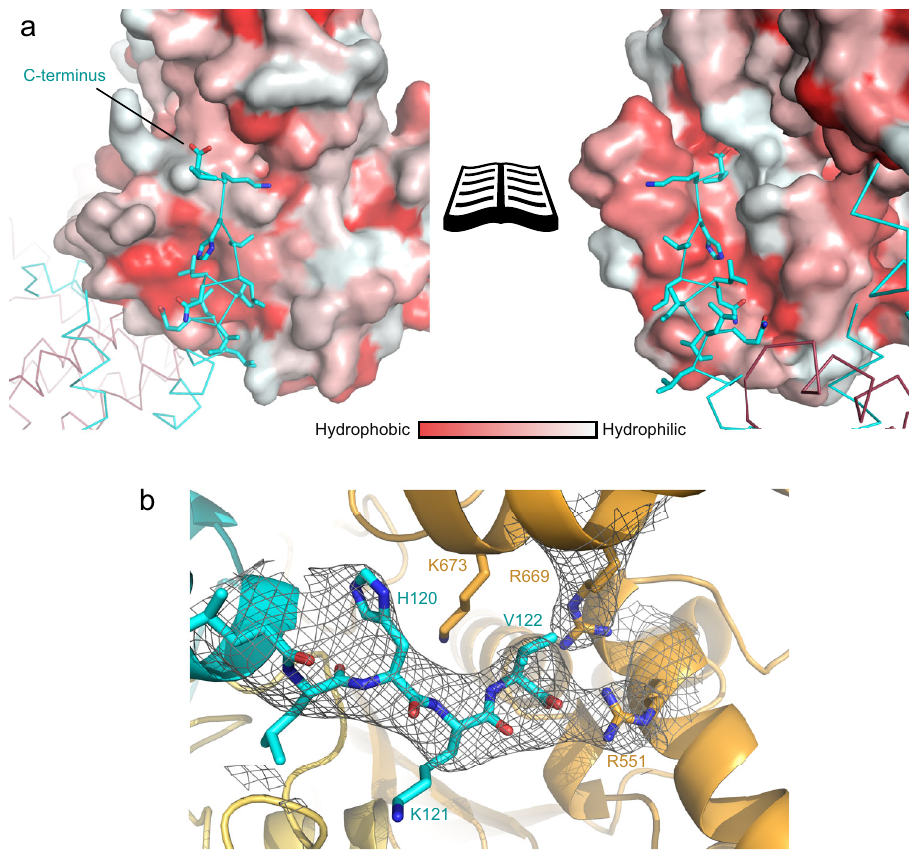
Fig. 5 The C-terminus of YscX binds between two YscV protomers. a Surface hydrophobicity of YscV (left) and the neighboring protomer (right) from hydrophobic (red) to hydrophilic (white) with a ribbon and stick representation of YscX (cyan). Helix α 3 inserts between two YscV molecules and binds via hydrophobic interactions. The C-terminus is pointing towards a positively charged patch of the neighboring subunit, which likely stabilizes the carboxylate. b 2m F O -D F C density contoured at 1 σ at the C-Terminus of YscX suggests positioning of the carboxylate towards R551 of YscV (orange). The density of the arginines is exemplary and varies between the